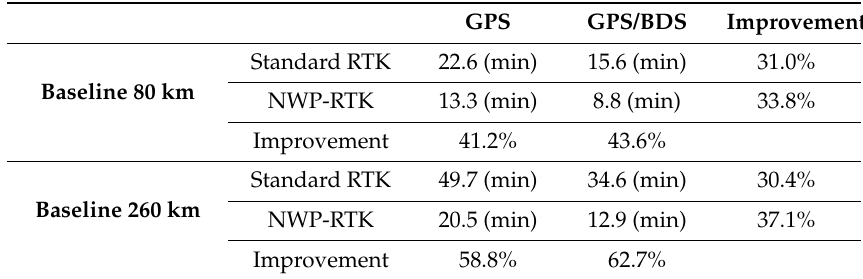
Table 3. Mean times for AR and the improvement of NWP-Constrained RTK (NWP-RTK) respecting to the standard RTK for both GPS/BDS and GPS Solutions.